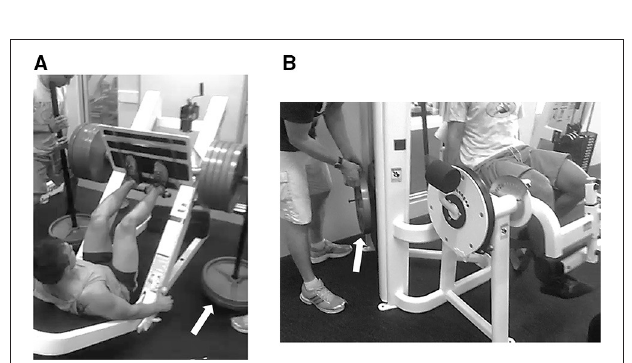
FIGURE 2 | Training equipment to allow accentuated eccentric loading. Inclined leg press with weight-releasers (A) and manually loaded/unloaded weight plates on the knee extension device (B)